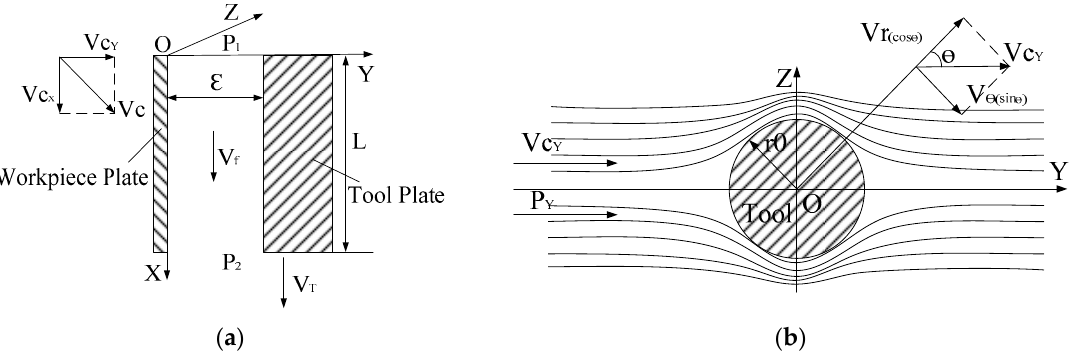
Figure 2. Schematics of inter-electrode gap. ( a ) The fluid speed along x axis; ( b ) The fluid speed along radial and circumferential.